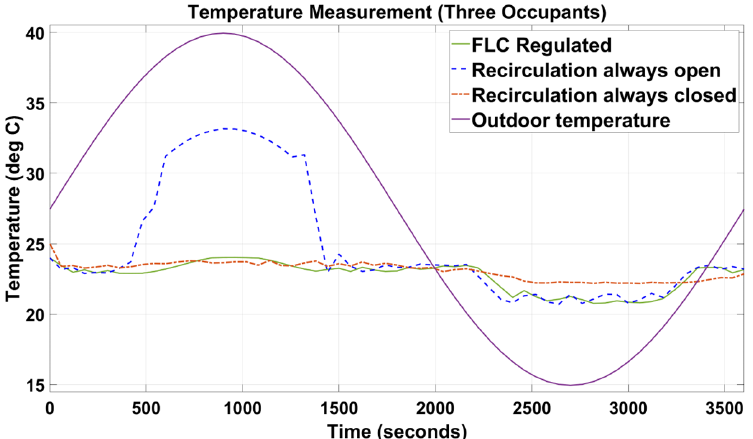
Figure 8. Indoor temperature of the simulated vehicle cabin with three occupants and outdoor tem ‐ perature.